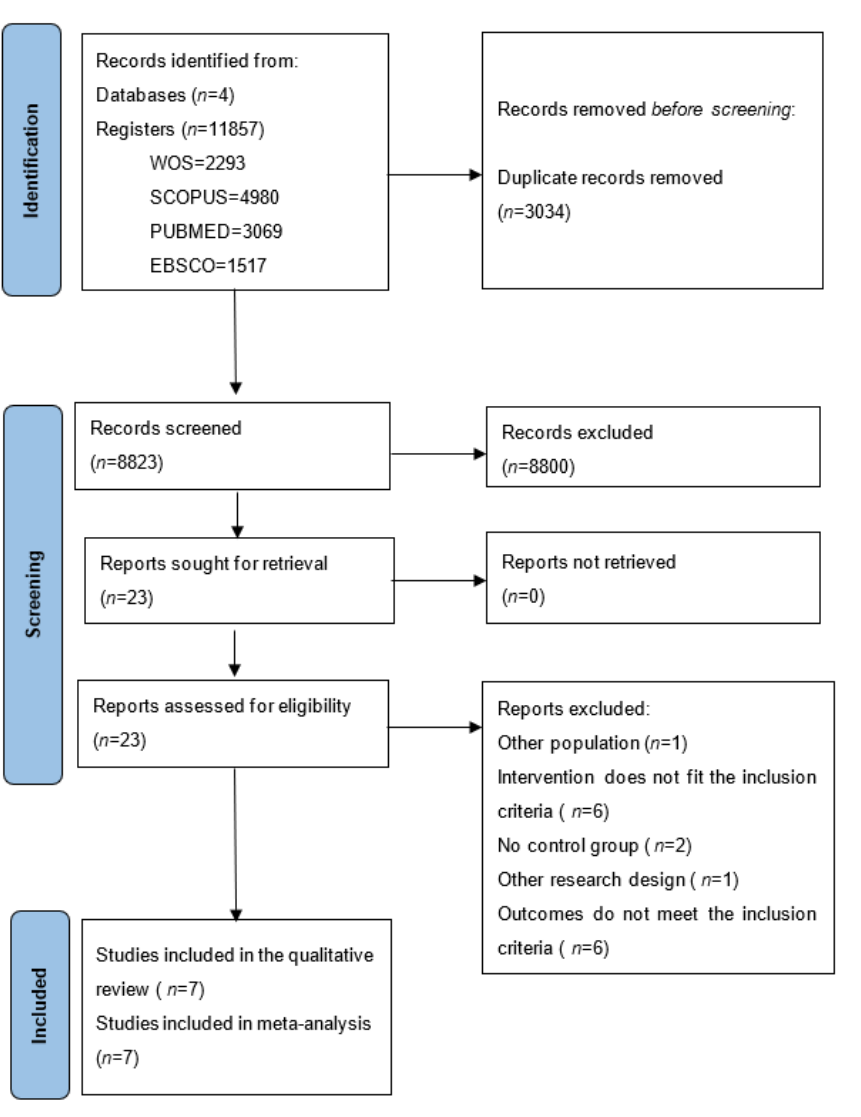
Figure 1. A flowchart of the studies included in the meta-analysis.